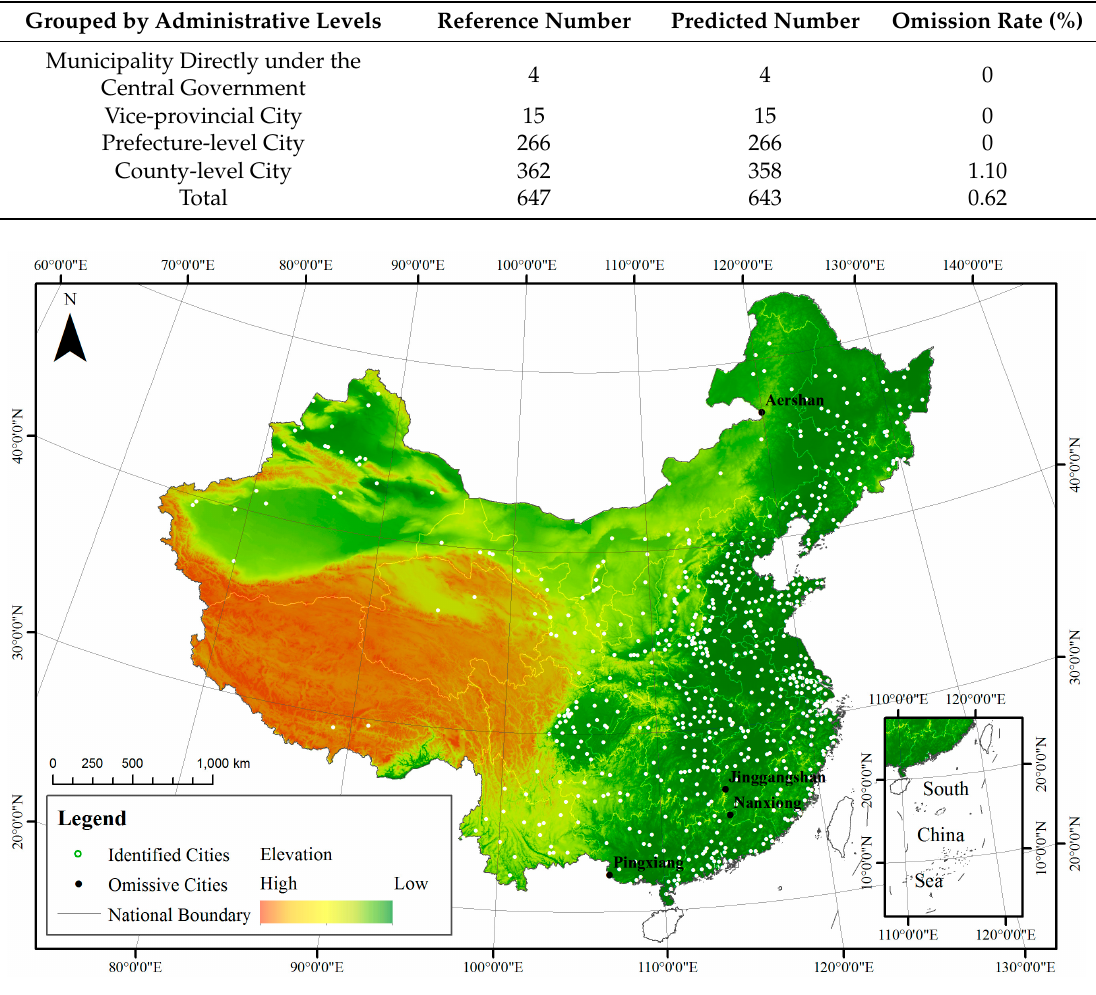
Figure 7. The distribution of 647 cities, represented by the locations of the administrative department.